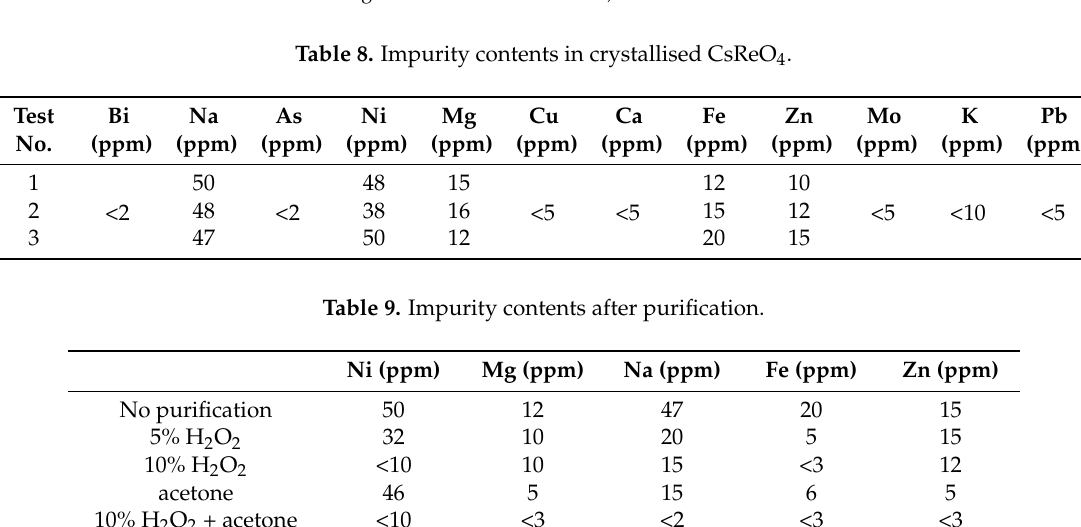
Table 8. Impurity contents in crystallised CsReO 4 .